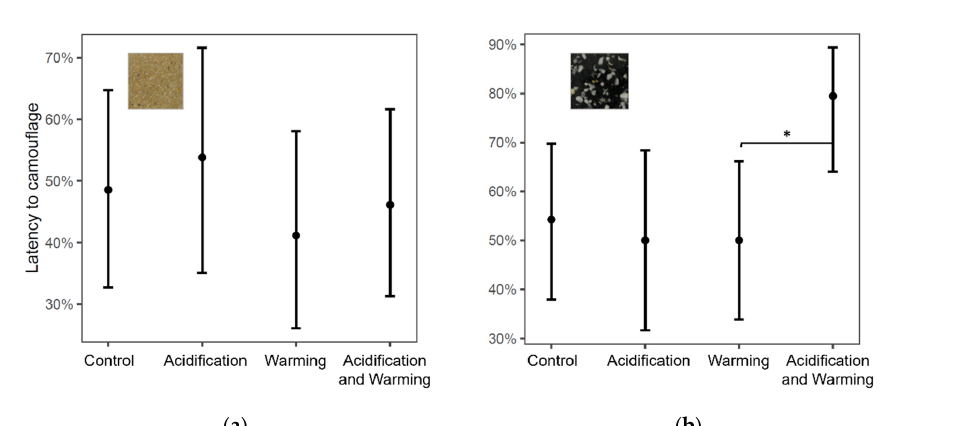
Figure 2. Proportion of cuttlefish exhibiting delayed camouflage in ( a ) sand; ( b ) gravel substrates, with relation to different treatments: control, acidification, warming, and acidification and warming. Points represent predicted means, and bars represent confidence intervals from generalized linear models (Binomial family). *: p < With respect to body planes pixel intensity differences in gravel, both W (LM, z = − 3.48, df = 134, p < 0.01) and AW (LM, z = 2.73, df = 134, p < 0.05) treatments significantly enhanced body pattern contrast compared with C (Figure 3). Moreover, body contrast was reduced when gravel was presented first (Wald chi-squared test, df = 1, χ 2 = 8.72, p < 0.01).